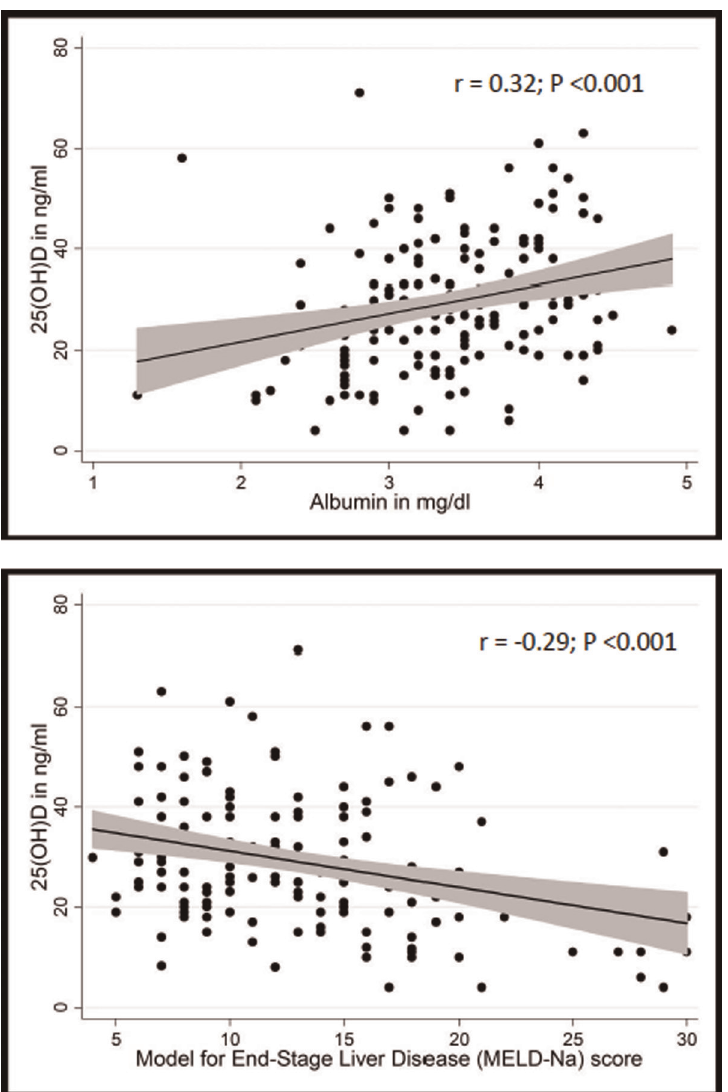
Figure 3. Scatterplots of 25-hydroxyvitamin D [25(OH)D] levels by serum albumin levels (top) and by MELD-Na scores (bottom) in patients with cirrhosis (n =